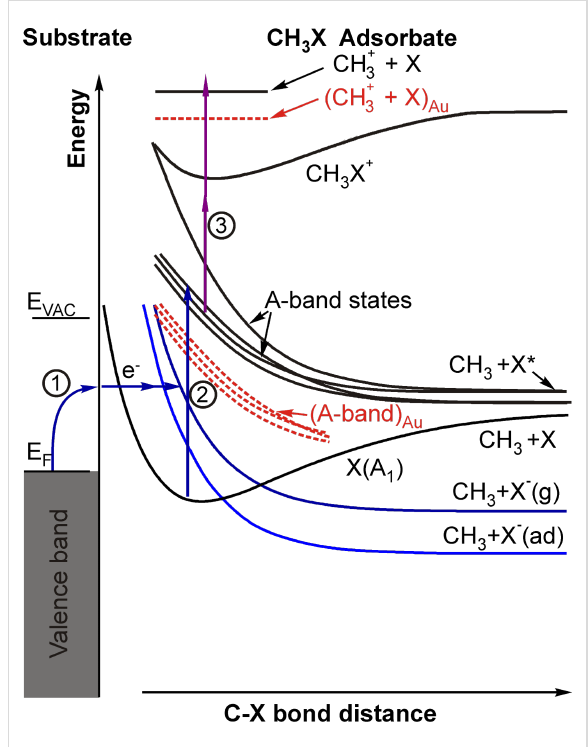
Figure 2: Schematic potential energy diagram for CH 3 X (X = I, Br, Cl) molecules adsorbed on a metal surface. The shape of the potentials and the general idea have been adapted from data on CH 3 Br in [7,24- 27]. The numbers of the excitation and detection mechanisms refer to the discussion in the text. The electronic levels that are proposed to be involved in the excitation and detection mechanism on the gold surface are indicated by the dashed red